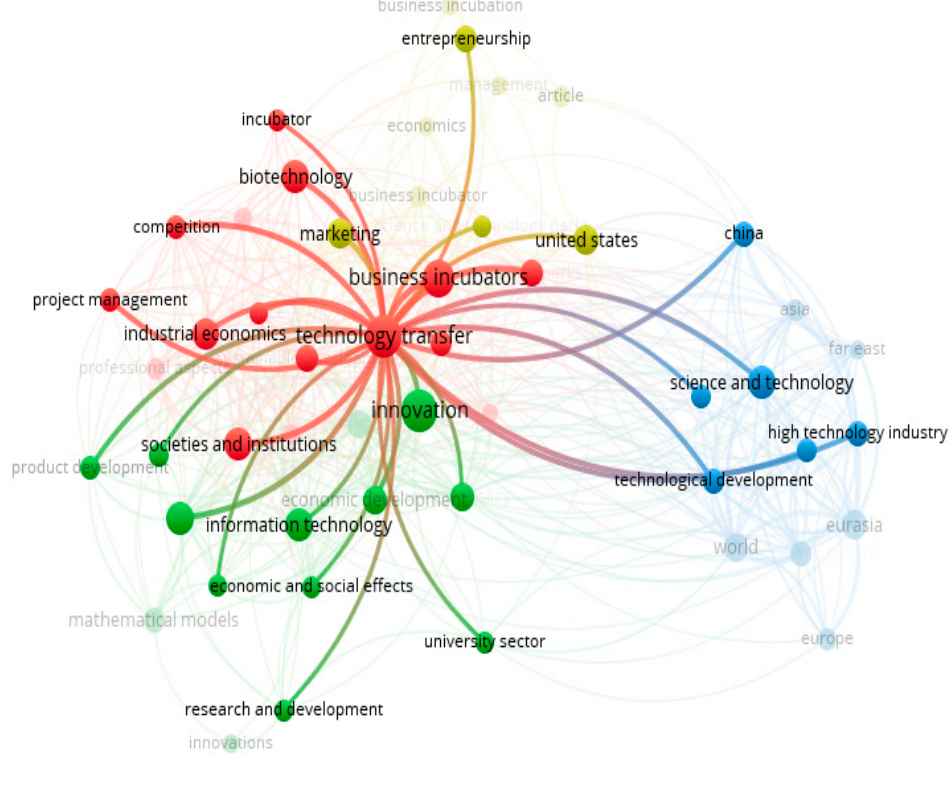
Figure 4. Cluster map